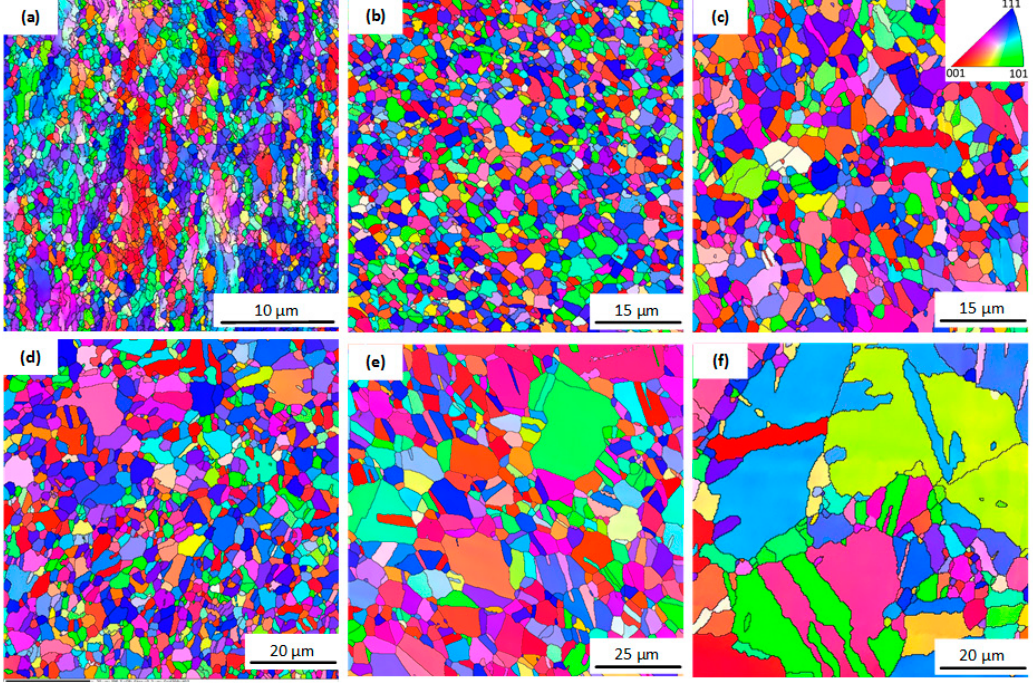
Figure 6. The inverse pole figures (IPFs) at different temperatures: ( a ) 160 °C; ( b ) 200 °C; ( c ) 240 °C; ( d ) 280 °C; ( e ) 320 °C; and ( f ) 360 °C .